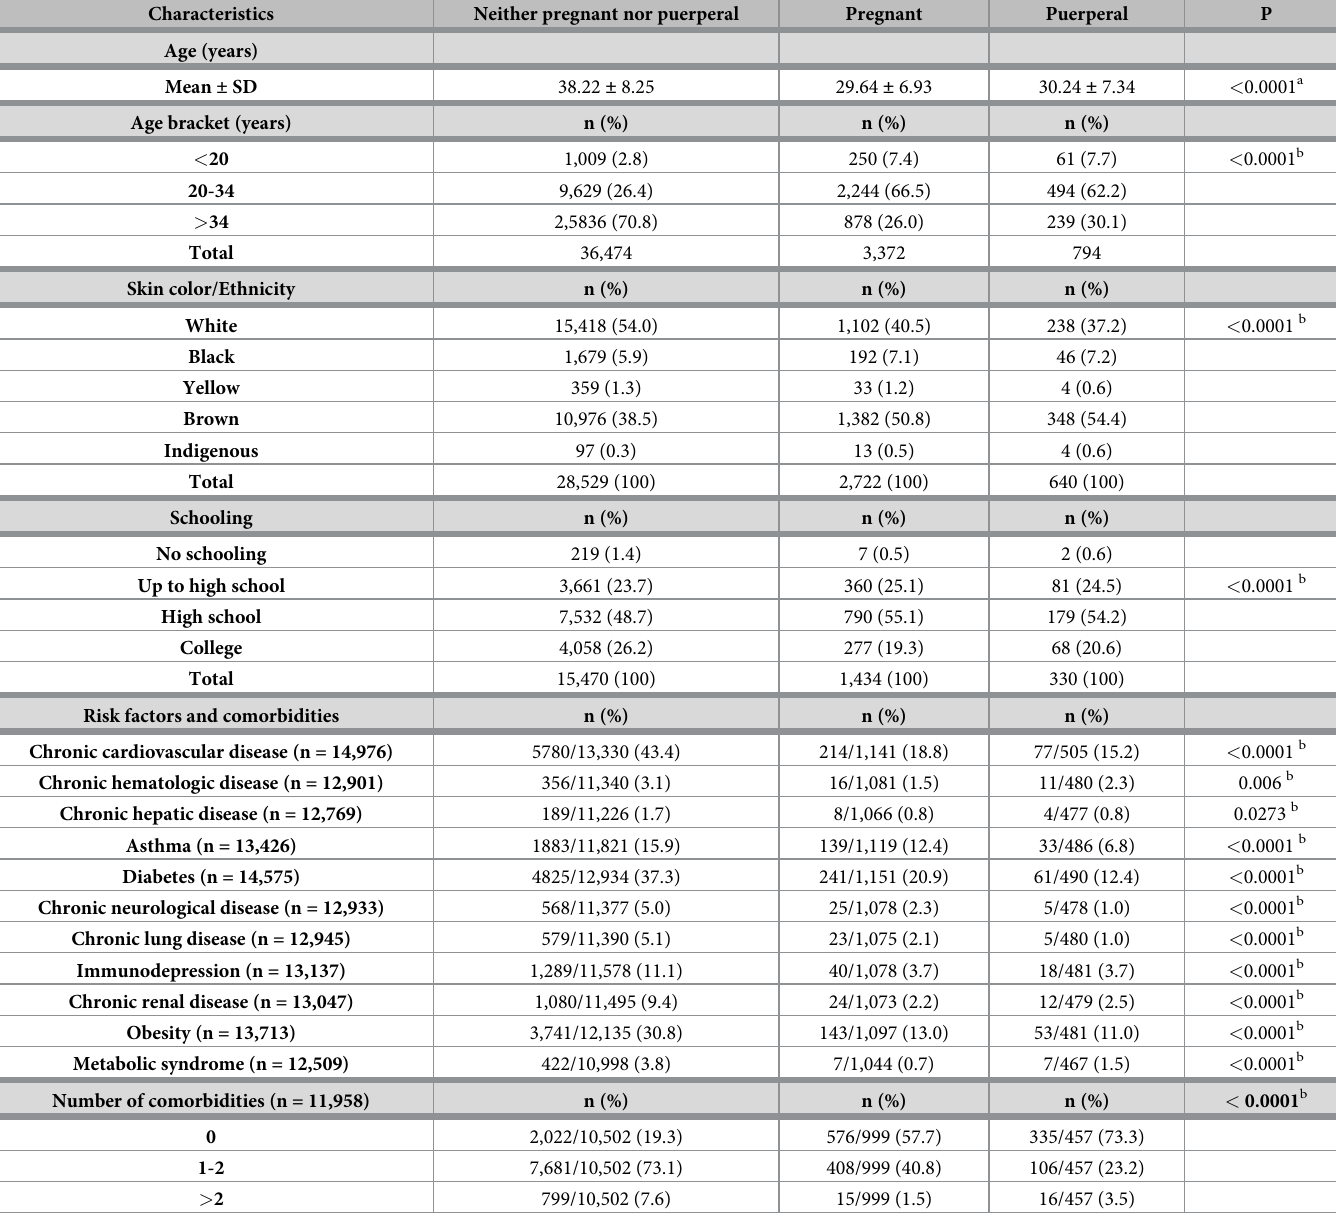
Table 1. Demographic and clinical characteristics of reproductive age women with COVID-19 according to gestational status – Brazil, February 17, 2020 – January 02, 2021.